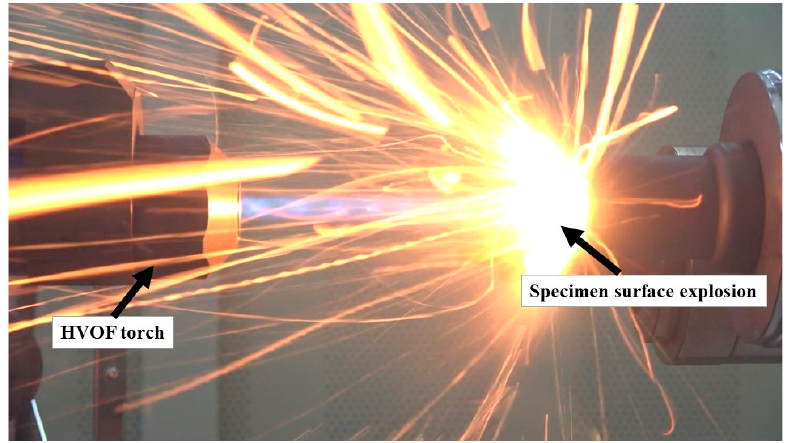
Figure 8. Explosion on CP (0°)-3 specimen surface.